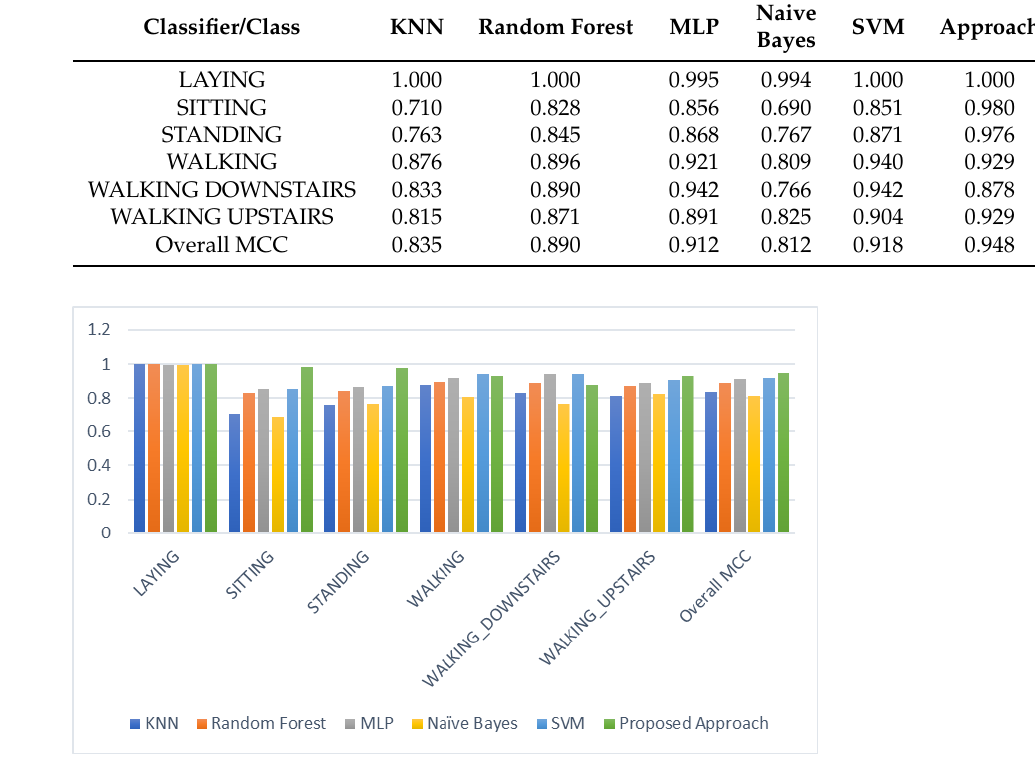
Figure 10. Detailed MCC by Class. Table 7. Performance measure for each